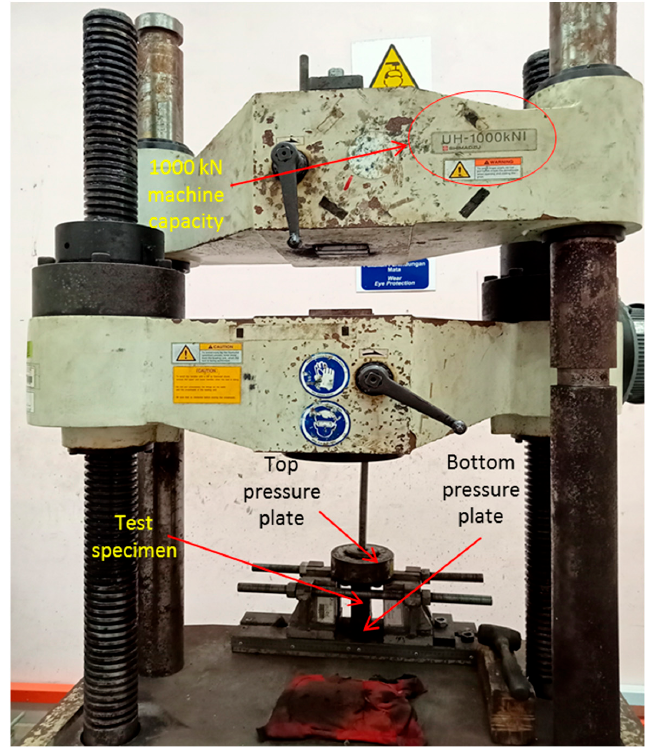
Figure 6. Mechanical test